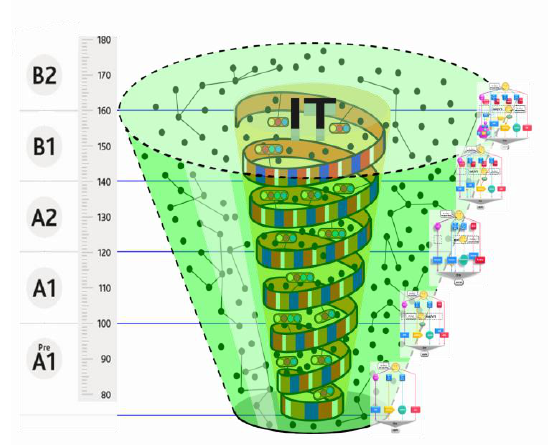
Fig. 9. Visual representation